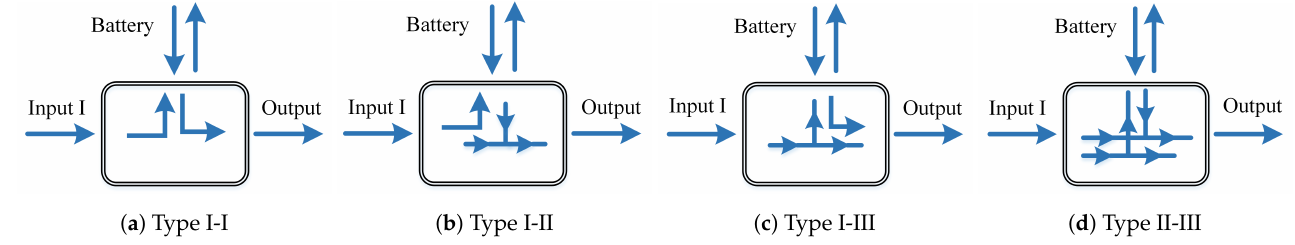
Figure 3. Power flow graphs of TPC with one of input ports being connected to battery as the bidirectional port